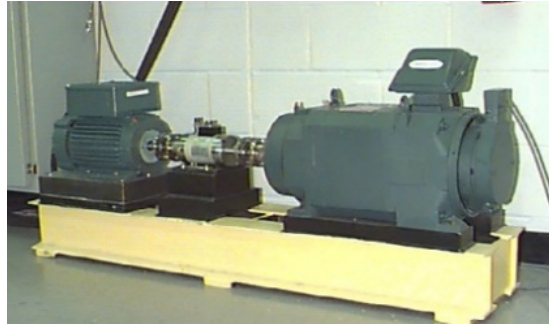
Figure 11. The experimental setup.